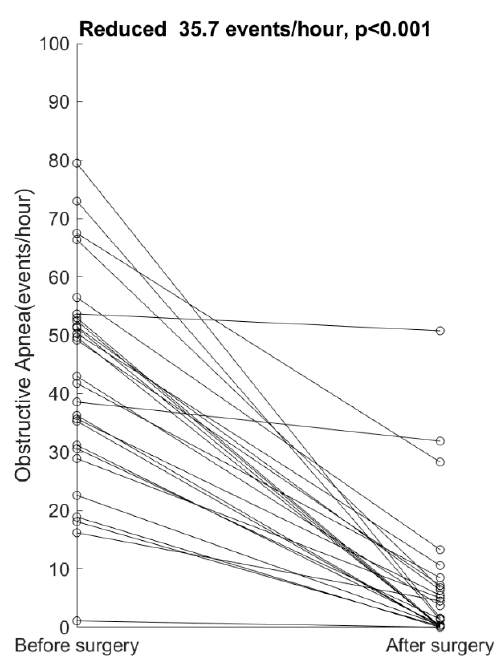
Figure 2. Individual obstructive apnea index changes revealed a significant reduction after the surgery.